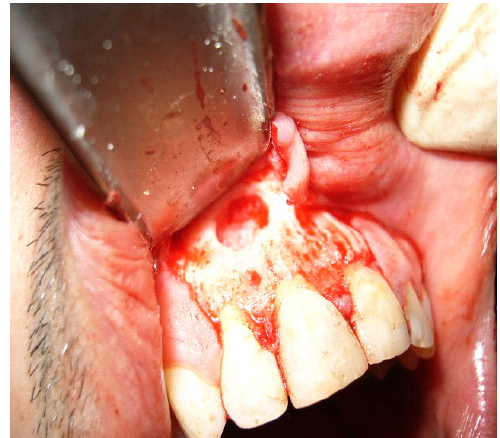
Figure (4): Apicectomy with periapical dental cyst enucleation for upper central incisor (Intra operative picture) The patient has been given clindamycine 600 mg 1 hr.